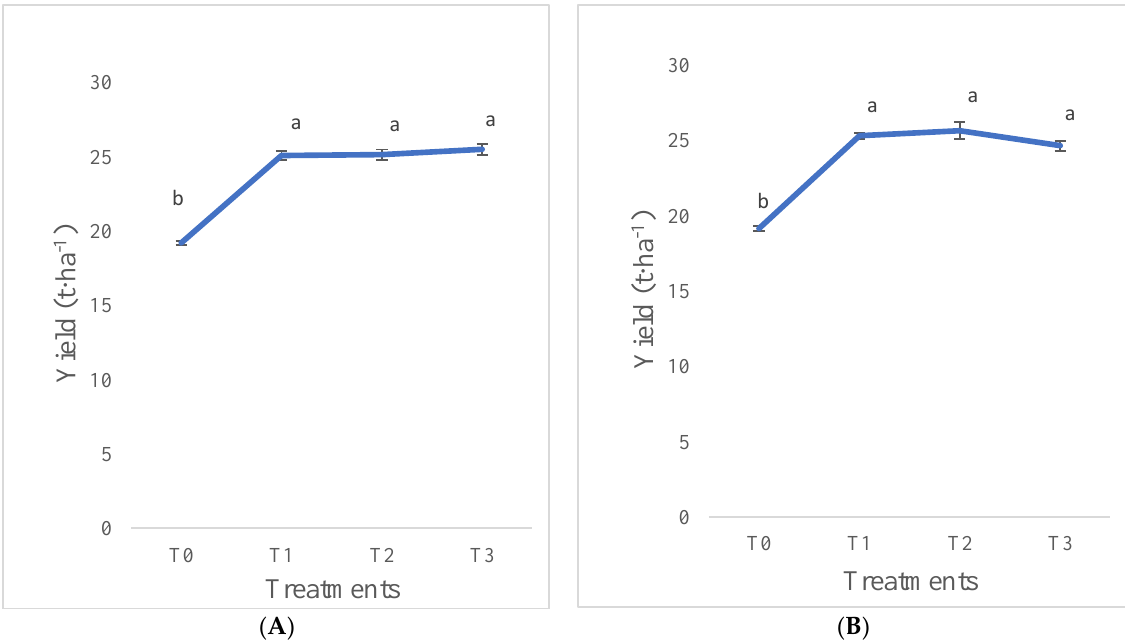
Figure 6. Yield of lucerne under inoculation with liquid formulation (T0, T1, T2, and T3) of Sinorhi- zobium meliloti in climatic zone ( A ) = Bronkhorspruit/Gauteng and ( B ) = Hartbeesfoein/Northwest Province). Bars sharing a letter are not significantly different (Lsd Zone A) = 0.940 and (Lsd Zone B) = 1.035. Data are means ± standard